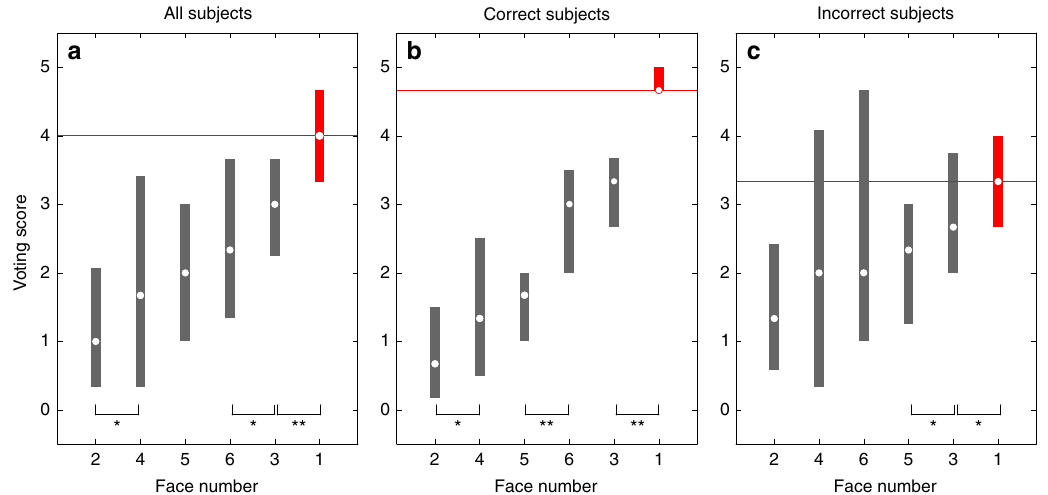
Fig. 4 Results of perceptual scaling in the target-present condition. Structure of recognition memory is revealed by voting scores obtained from the paired comparison (PAR) target-present lineup: for all subjects in ( a ) ( N = 62 subjects, who also appear in Fig. 3a), for subjects who exhibited top-rank voting scores for the target face (F1) in ( b ) ( N = 20 subjects), and for subjects who exhibited top-rank voting scores for non-target faces in ( c ) ( N = 37 subjects). (The fi ve subjects, for whom there were voting score ties for top rank, are included in ( a ), but not in ( b ) or ( c ).) Circles represent medians. Vertical bars represent interquartile ranges. Signi fi cant differences between the faces in adjacent ranks are indicated by single ( p < 0.05) or double ( p < 0.01) asterisks. A nonparametric statistical test was used to evaluate differences, as described in Methods (section Perceptual scaling of lineup faces). This is a one-sided statistical